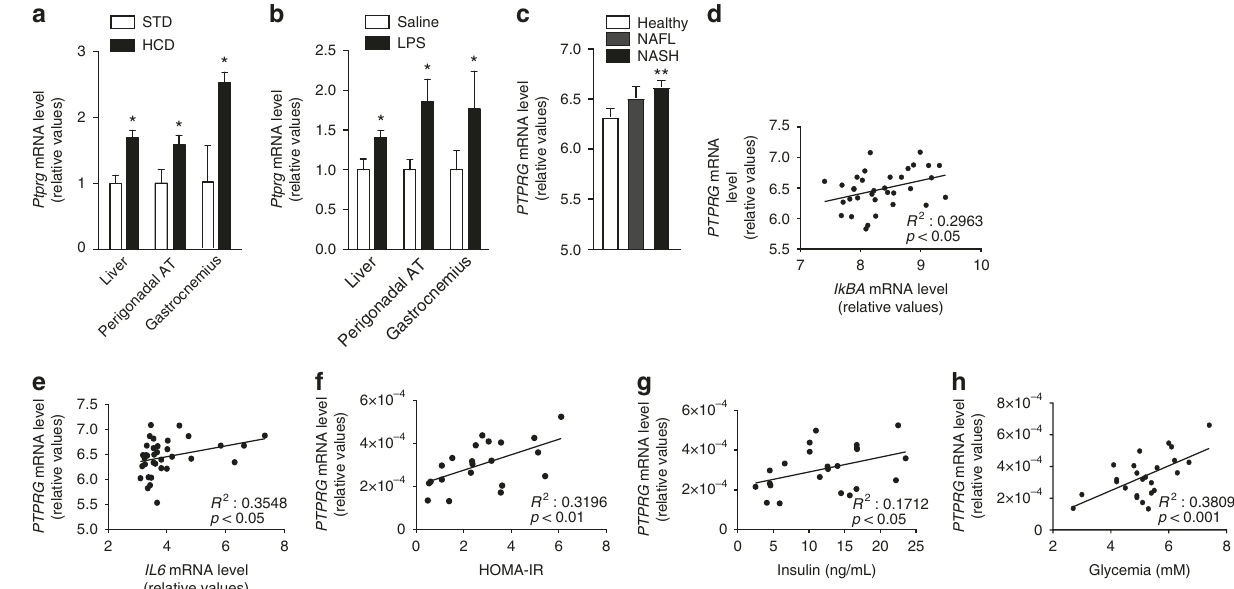
Fig. 1 Hepatic PTPR- γ expression correlates with in fl ammation and insulin resistance in mice and humans. a Hepatic Ptprg mRNA expression level of 30- week-old wild-type mice fed either on a STD or a HCD ( n = 8 per group). b Hepatic Ptprg mRNA expression level in mice treated with LPS or saline ( n = 4 per group). c Hepatic PTPRG mRNA expression level in patients with non alcoholic fatty liver (NAFL) ( n = 10) or non-alcoholic steatohepatitis (NASH) ( n = 16) compared to healthy subjects ( n = 19) from publicly available microarray E-MEXP-3291. d – h Correlation between hepatic PTPRG mRNA expression and d hepatic IkBA mRNA level, e hepatic IL6 mRNA level, f HOMA index, g plasma insulin level, and h glycemia in humans ( n = 33). Error bars represent SEM. Statistical analyses were done using two-tailed unpaired Student ’ s t test. * P < 0.05. Correlation analyses were performed by using the Spearman rank-correlation test. See also Supplementary Fig.